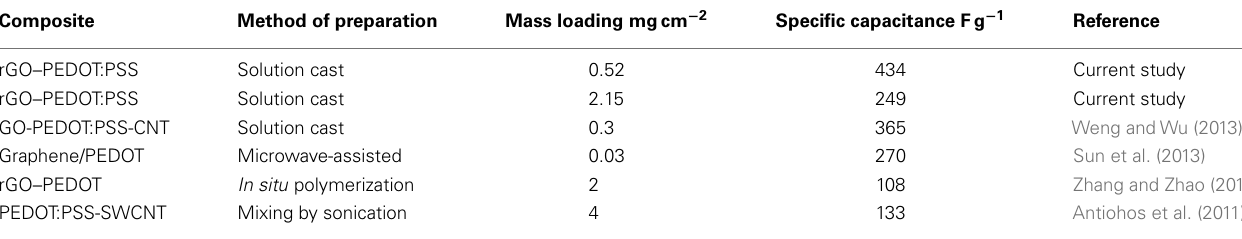
Table 1 | Graphene/CNTs–PEDOT:PSS based composites used as supercapacitor electrode material .